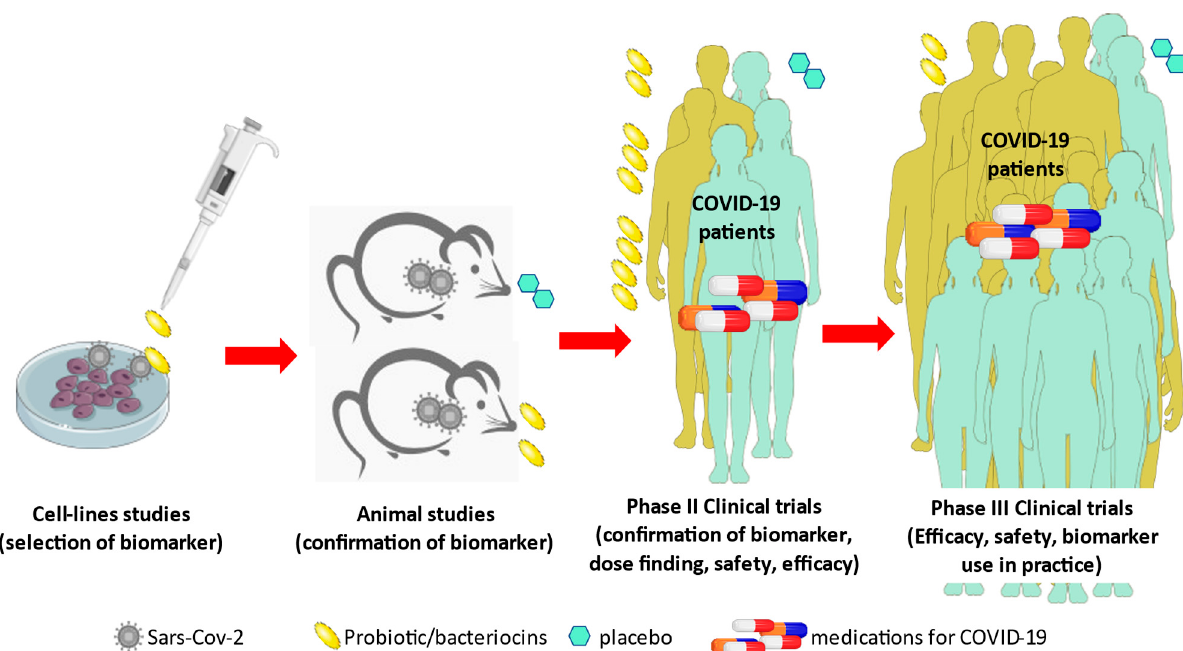
Figure 4. Proposed schedule of studies and their outcome measures to establish probiotic administra- tion as supplementary treatment of COVID-19.